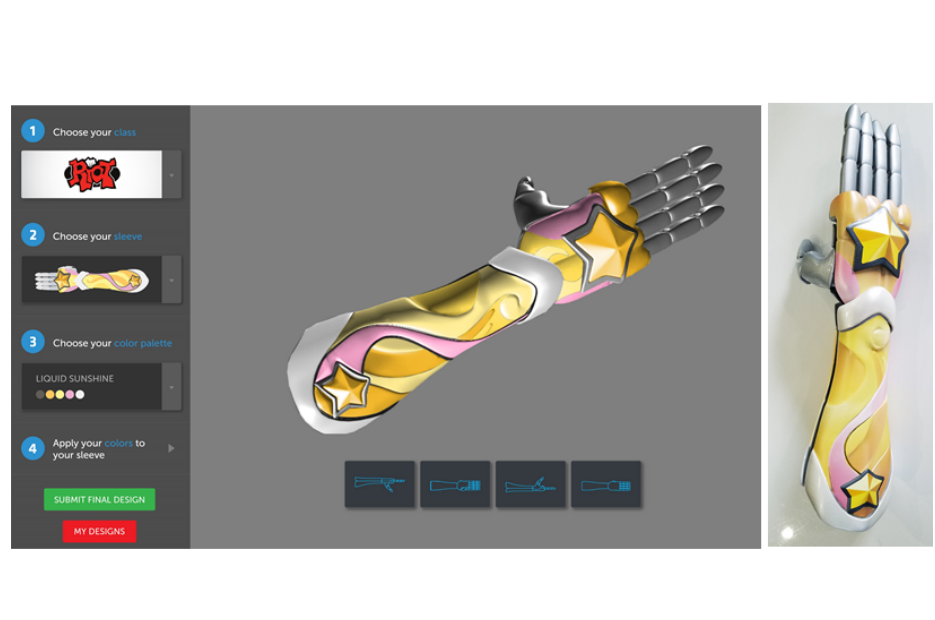
Figure 5. ( Left ) Example interactive web page for children to customize color and effect regions during the design process, and how user participation can be translated to ( Right ) the final design with artistic input from art team and production teams. Sleeve design made in partnership with Riot Games.